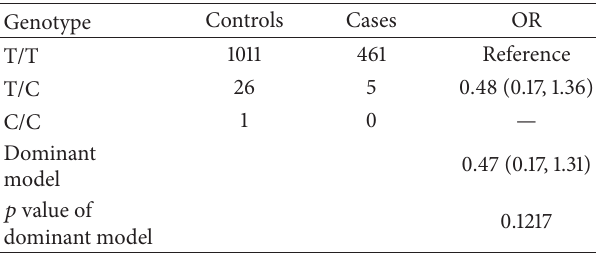
Table 3: Logistic regression analysis showing no association between individual SNP and